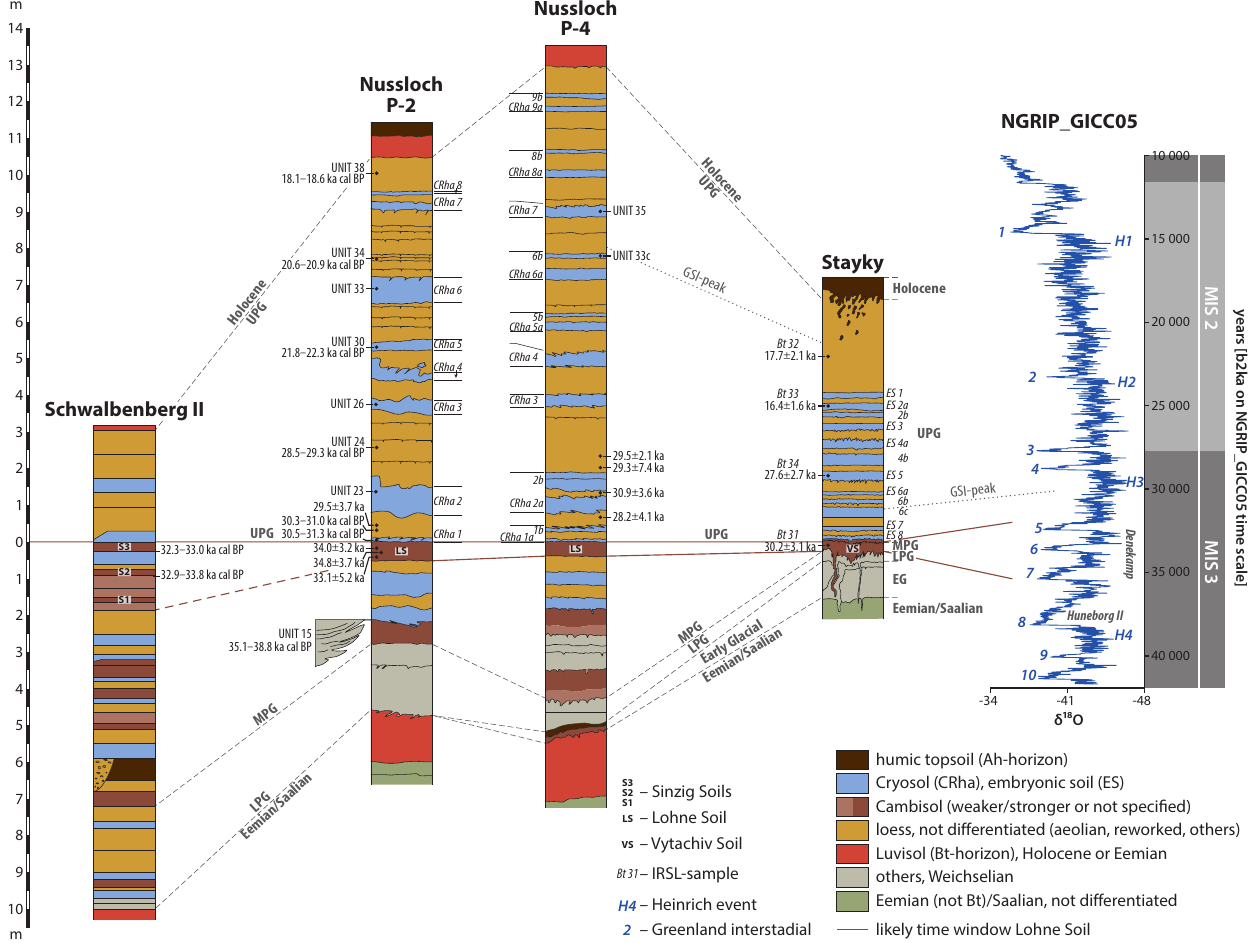
Fig. 2. Simplified sketches of the loess sections Schwalbenberg II (after Schirmer 2012), Nussloch (after Antoine et al., 2009) and Stayky (after Rousseau et al., 2011). Luminescence ages “age ± error” ka, 1 σ , with reference to the year of publication. 14 C age ranges “age – agekacalBP”, 1 σ , with reference to 1950AD. Calibration CalPal-2007 HULU (Weninger et al., 2012). NGRIP_CiCC05 timescale after Andersen et al. (2006) and Svensson et al. (2006), with reference to 2000AD. Nussloch presented with luminescence ages from around LS (unit 20, after Antoine et al., 2009) and 14 C ages from samples evaluated as especially reliable by Antoine et al. (2009). Age range 38750–35130acalBP for thermokarst infilling (unit 15, after Antoine et al., 2009) based on 14 C ages from ten wood samples matching time window for GIS8 on NGRIP_CICC05 timescale ca. 38300–35500ab2k (cf. compilation of 14 C ages in Kadereit et al., 2013, Fig. S2 in the Supplement: lower age boundary sample ETH-21511 (33040, 440); upper age boundary sample GIF/LSM-10442 (31800, 400)). Time window around uppermost MPG soil stratigraphically apparently best resolved at the Schwalbenberg II section (three individual soils, S1–S3). Correlation of S2 with GIS6 and S3 with GIS5, respectively, as suggested by 14 C dating at the site and time windows of GIS6 and GIS5 within the NGRIP_CICC05 timescale (cf. Fig. S2 in the